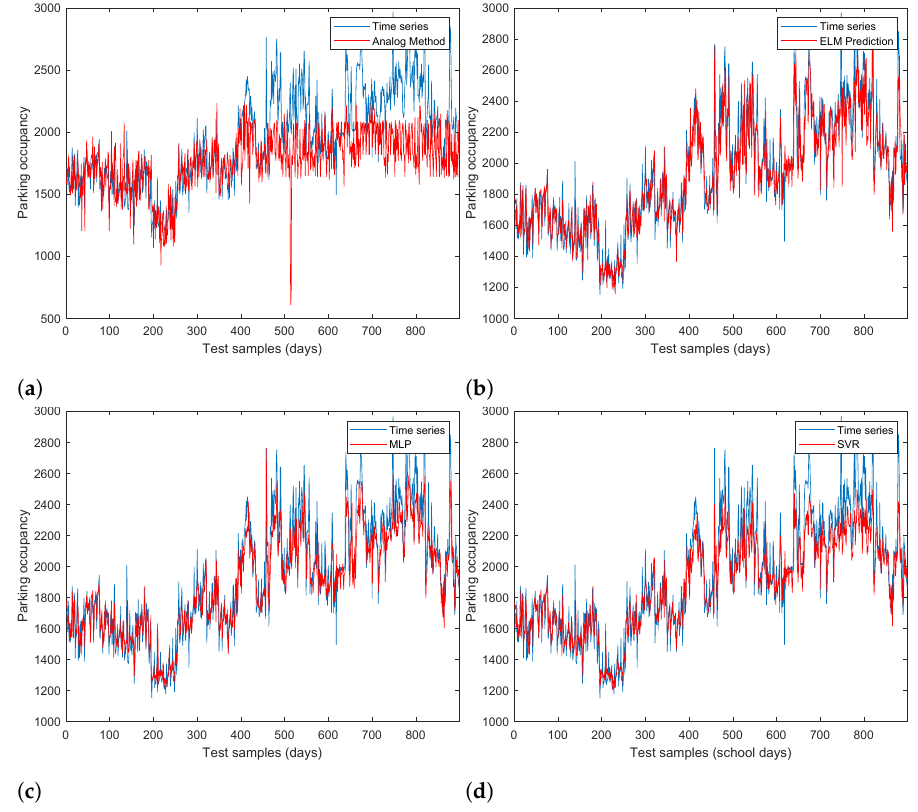
Figure 6. Performance of the different regressors considered in the prediction problem on San Sebastian parking occupancy dataset. ( a ) ANA; ( b ) ELM; ( c ) MLP; ( d ) SVR.